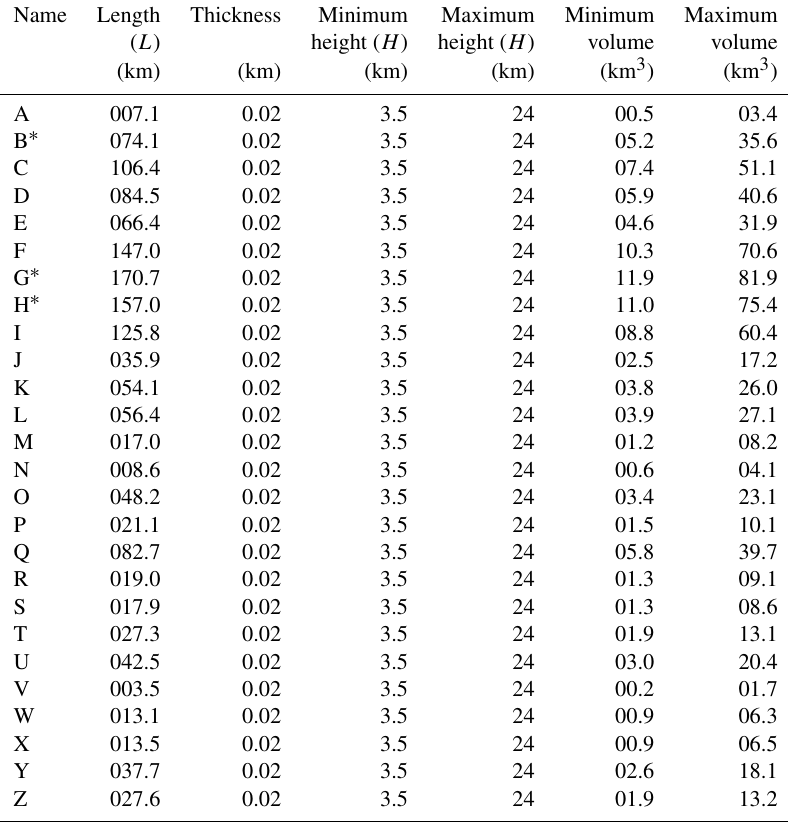
Table 2. Dyke volume